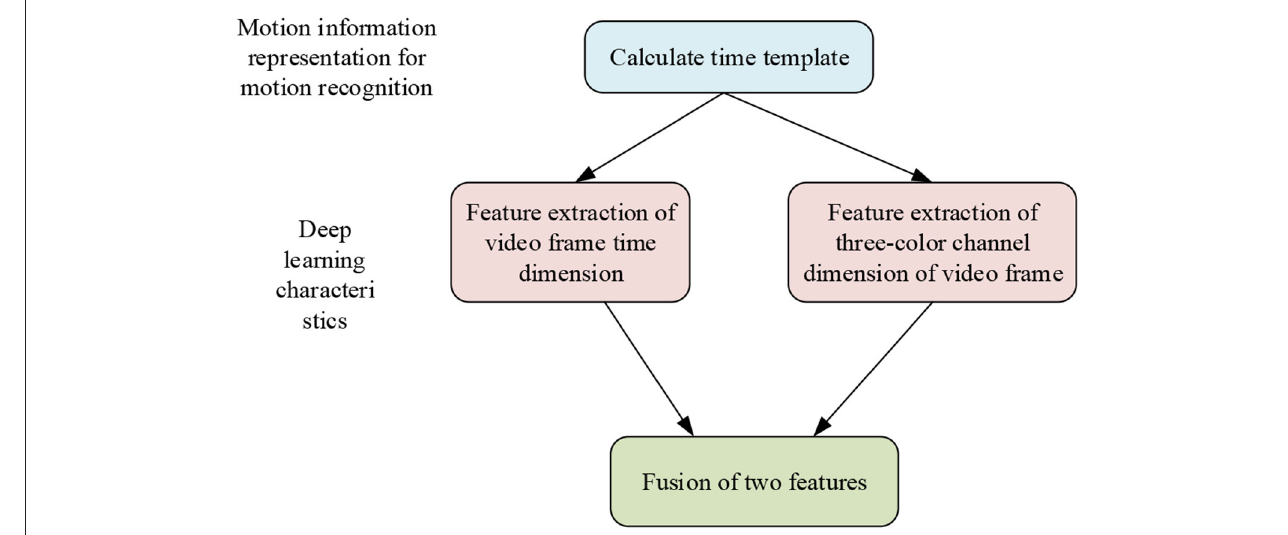
FIGURE 5 | DL in the field of sports competition.